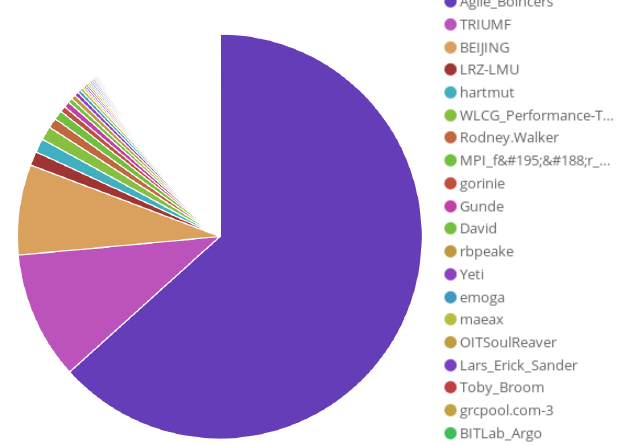
Figure 3. CPU consumption per volunteer from 1 March to 1 September 2018